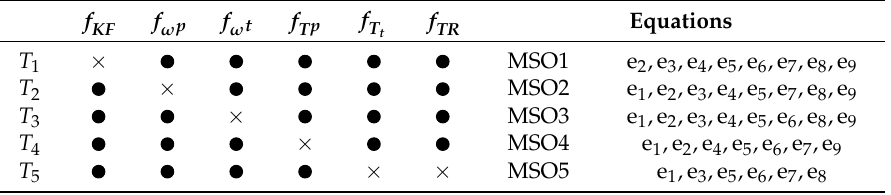
Table 4. Minimal structurally overdetermined (MSO) sets of the